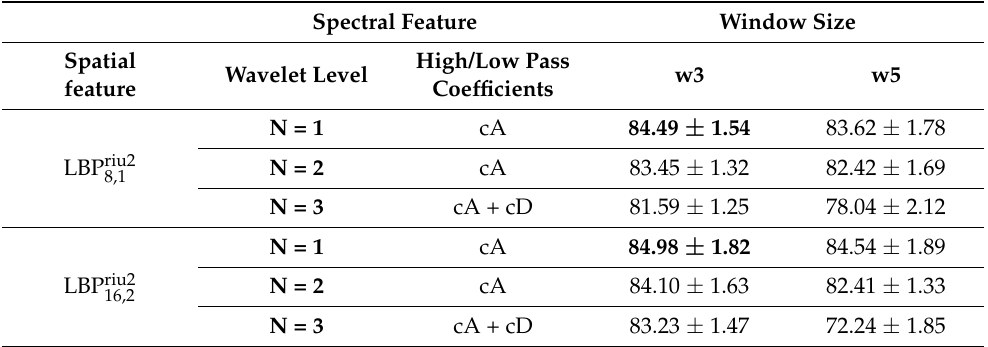
Table 4. Classification accuracy for the Indian Pines dataset, without filtering, with wavelet transform up to three levels, with the corresponding window size, of dimension 3 × 3 and 5 × 5, for the controlled sampling strategy and LBP histogram computation, w3 and w5